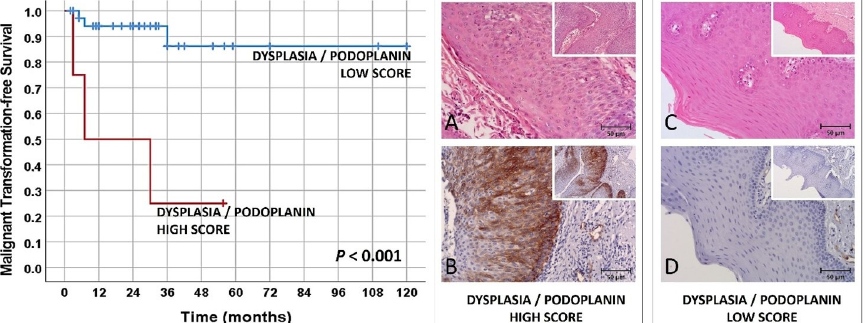
Figure 3. Kaplan–Meier analysis of oral malignant transformation-free survival in patients with oral leukoplakia using a combined score of binary dysplasia grade and podoplanin expression ( p < 0.001 Kaplan–Meier analysis). ( A , B ) Oral leukoplakia of high dysplasia grade and high expression of podoplanin; ( C , D ) oral leukoplakia with low dysplasia grade and low expression of podoplanin; ( A , C ) hematoxylin-eosin staining; and ( B , D ) podoplanin immunostaining. Small boxes inside the main photos (magnification × 200) correspond to the original image at magnification ×